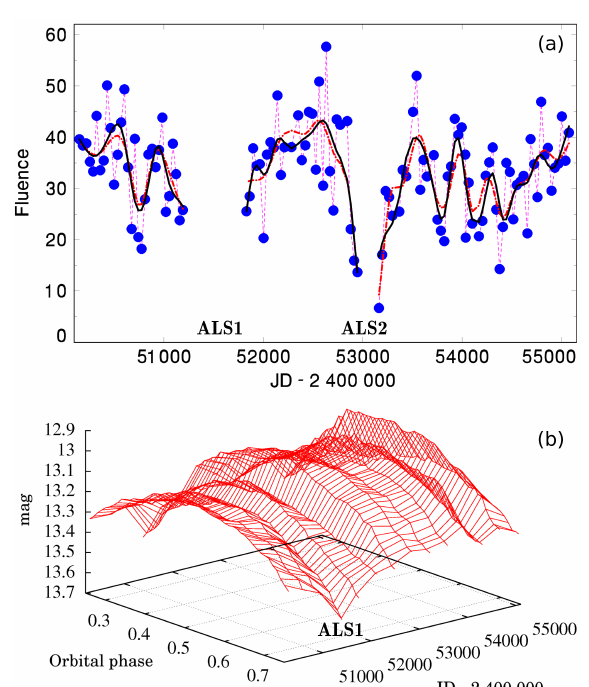
Figure 3: (a) Time evolution of fluence of Main-On states (1.5–12 keV) in Her X-1. Each episode of this state represents a point in the curve. The smooth lines represent the fits to the time evolution. (b) Smoothed evolution of the optical orbital modulation of Her X-1 with time. See Sect. 4 for